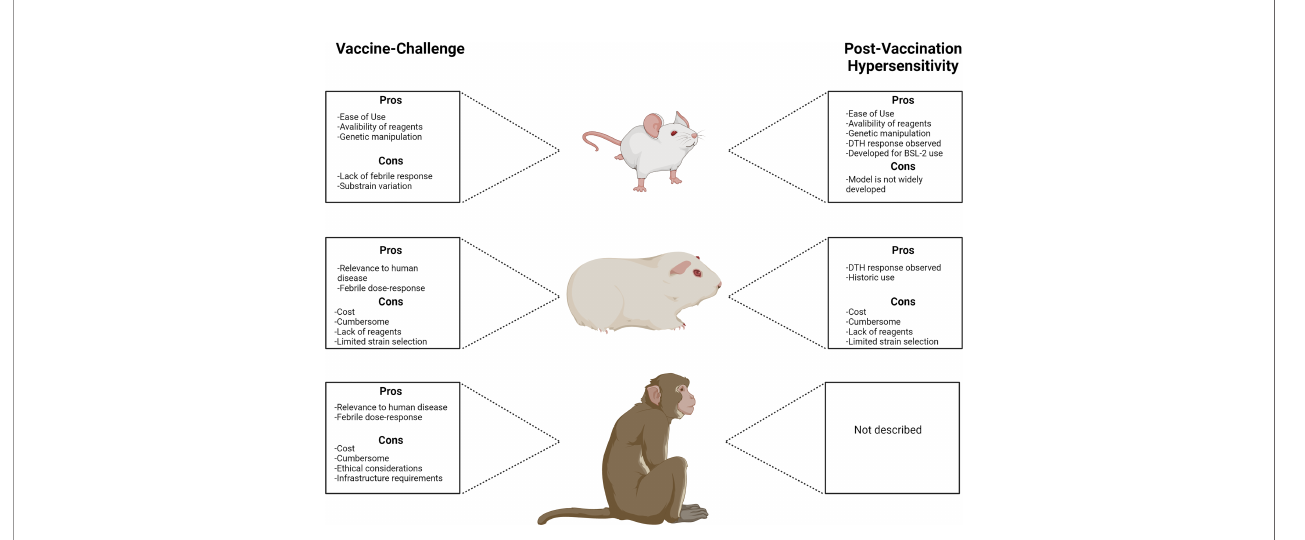
FIGURE 1 | Comparison of animal models used for Q fever vaccine development with principal advantages and disadvantages associated with each